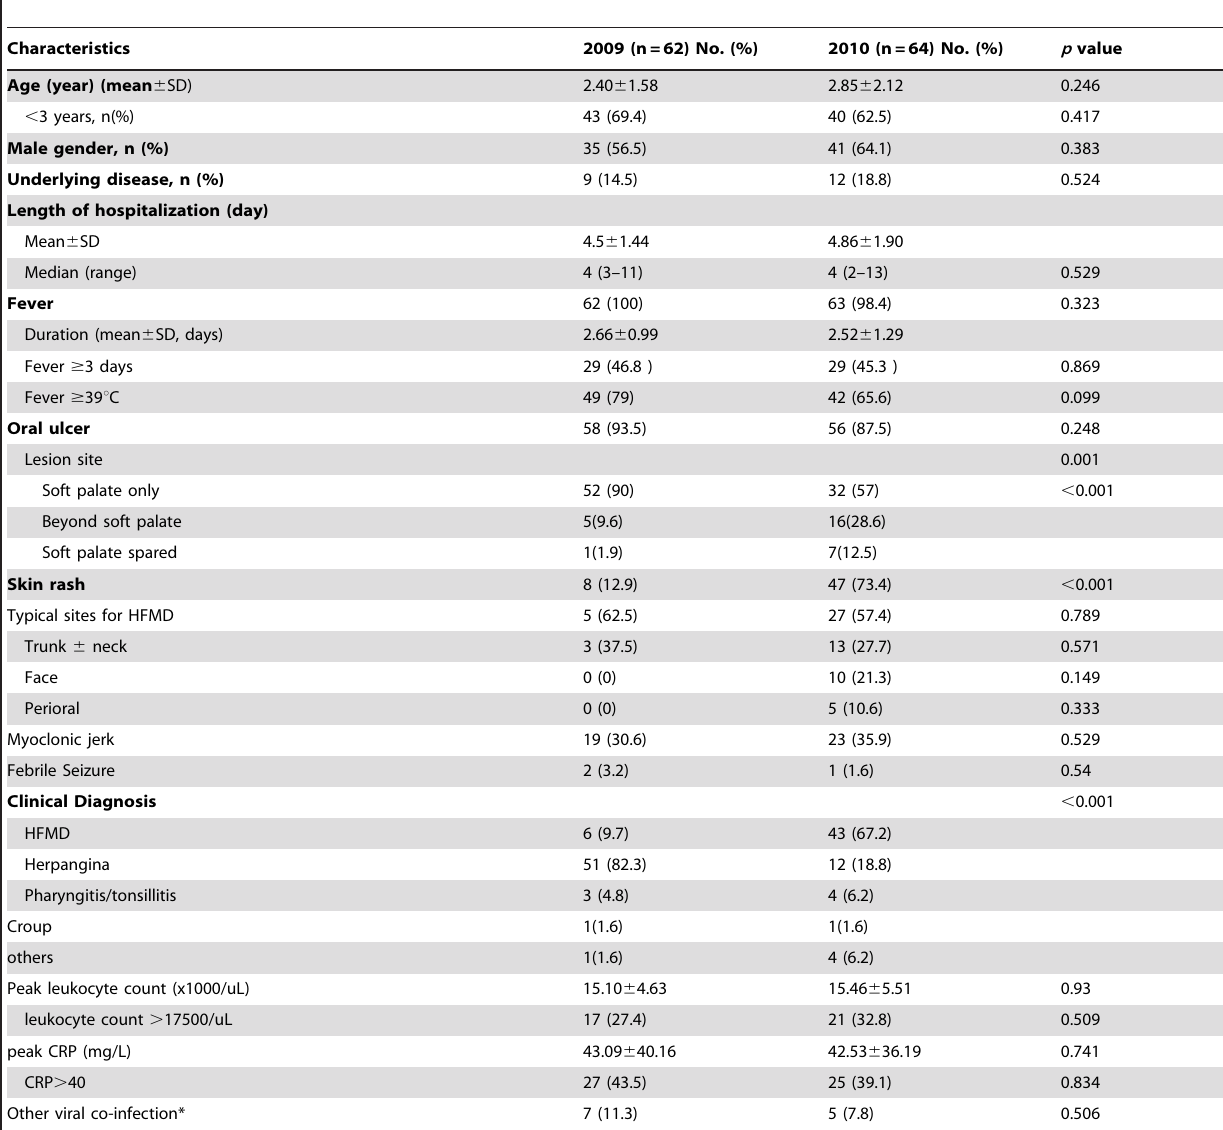
Table 1. Comparisons of demographics, clinical manifestations and laboratory data between inpatients with coxsackievirus A6 infection in 2009 and 2010 in